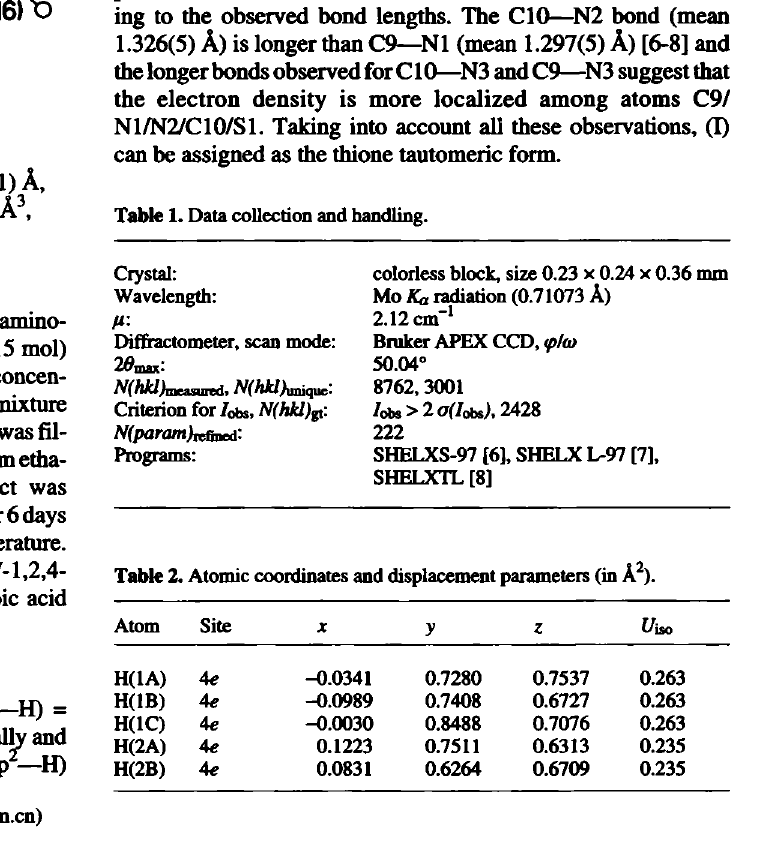
Table 1. Data collection and handling.